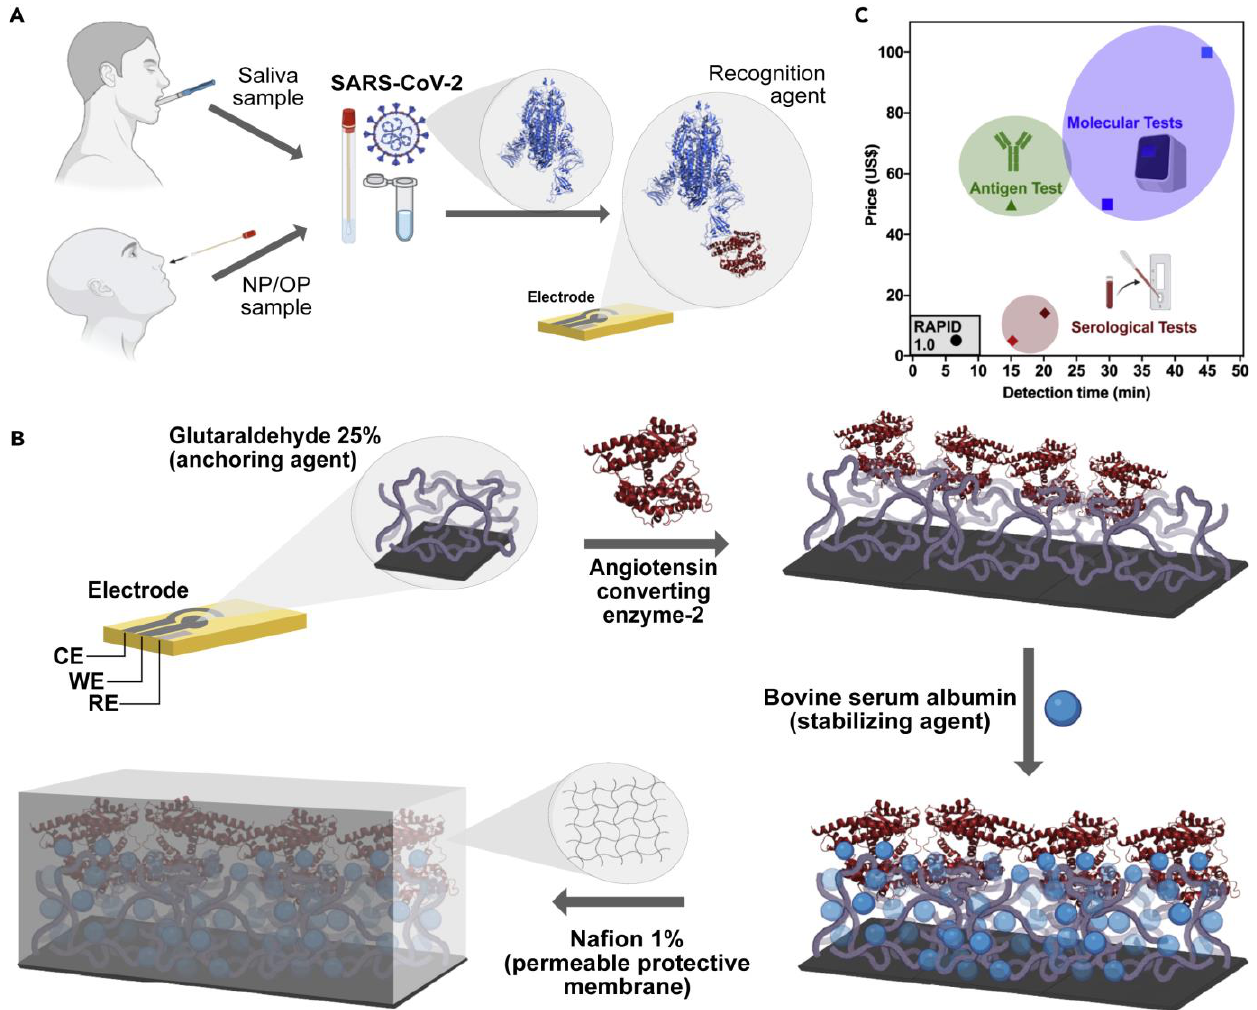
Figure 5. SARS-CoV-2 detection by RAPID test. ( A ), Working principle of RAPID test. ( B ), Func- tionalization of working electrode. ( C ), Comparison of RAPID test with some FDA-approved tests. Reprinted from Ref. [51] with permission from Elsevier. © 2021 Elsevier Inc.